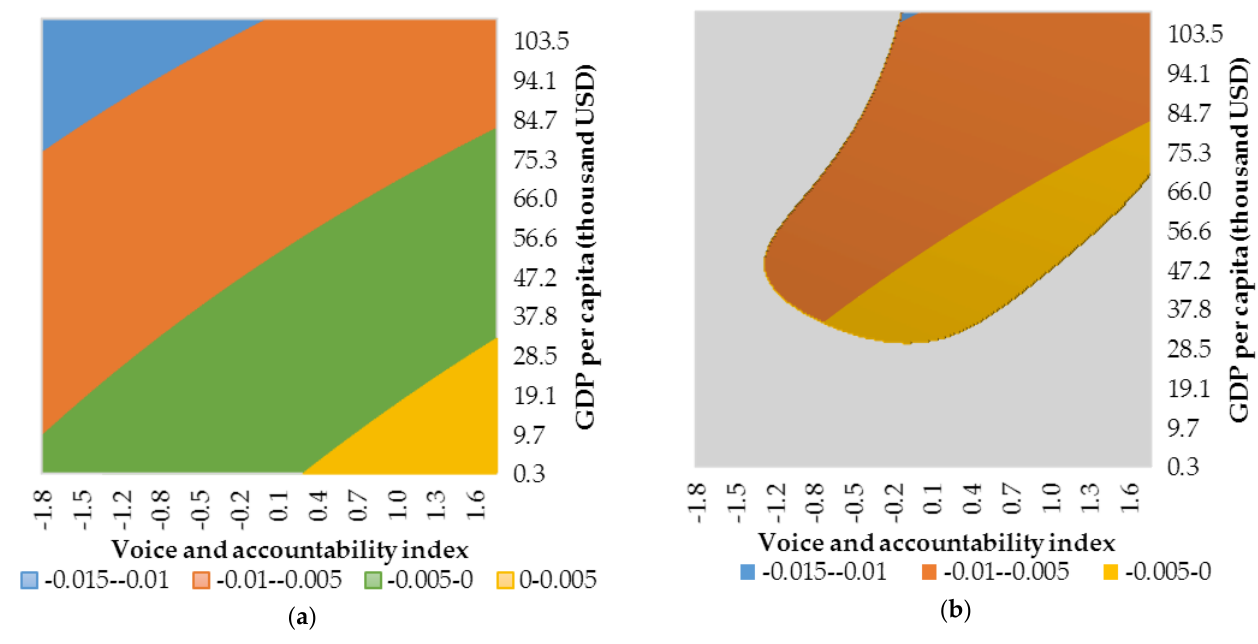
Figure A23. Conditional effect of financialisation on growth based on Est. 23 in Table A2. ( a ) Estimated conditional slope coefficient over the whole range of observed values for institutional quality and development level. ( b ) Estimated statisti- cally significant conditional slope coefficient. Gray represents a combination of institutional quality and development level for which effect of financialisation on growth is statistically insignificant. Source: authors’ contributions.